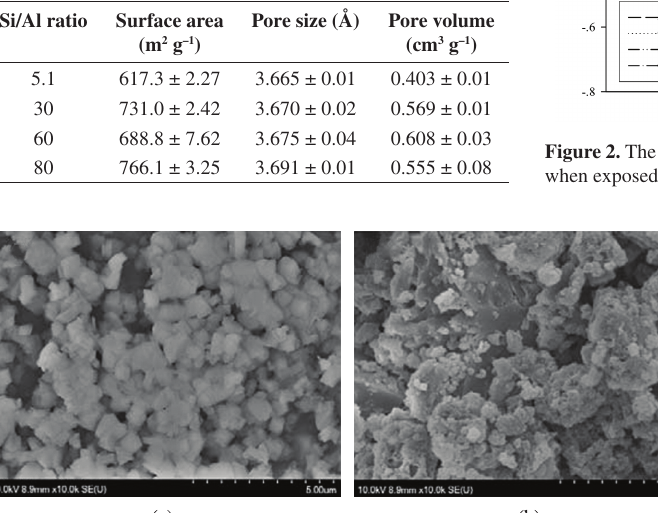
Table 1. Physical characteristics of Y_H +